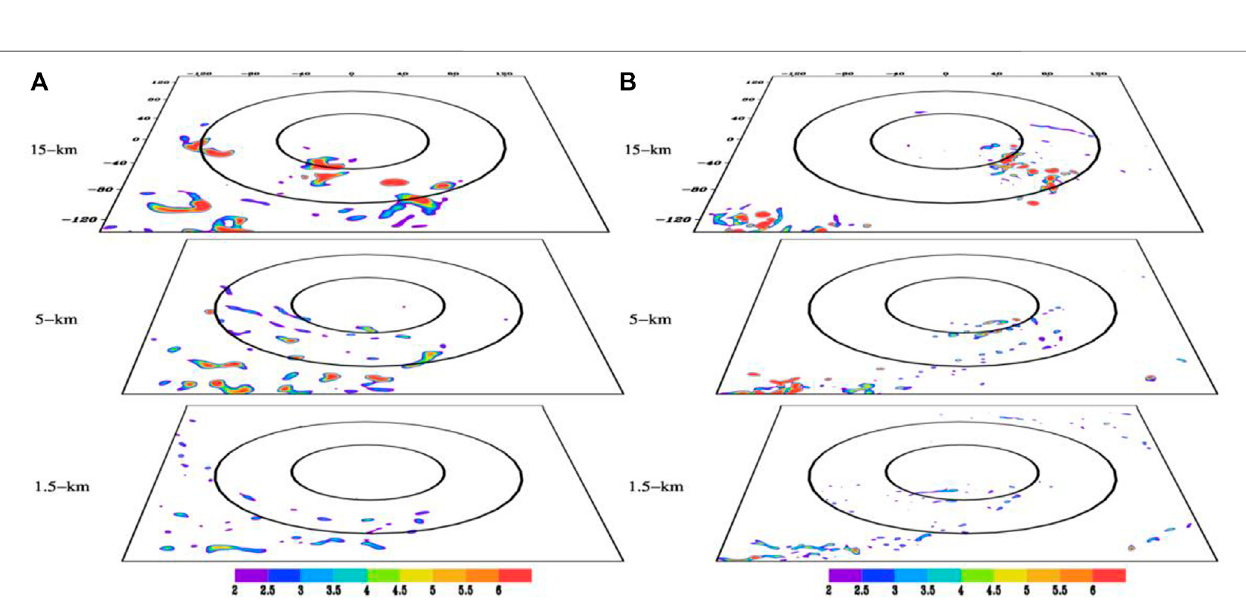
FIGURE 4 | As in Figure 3 , but in